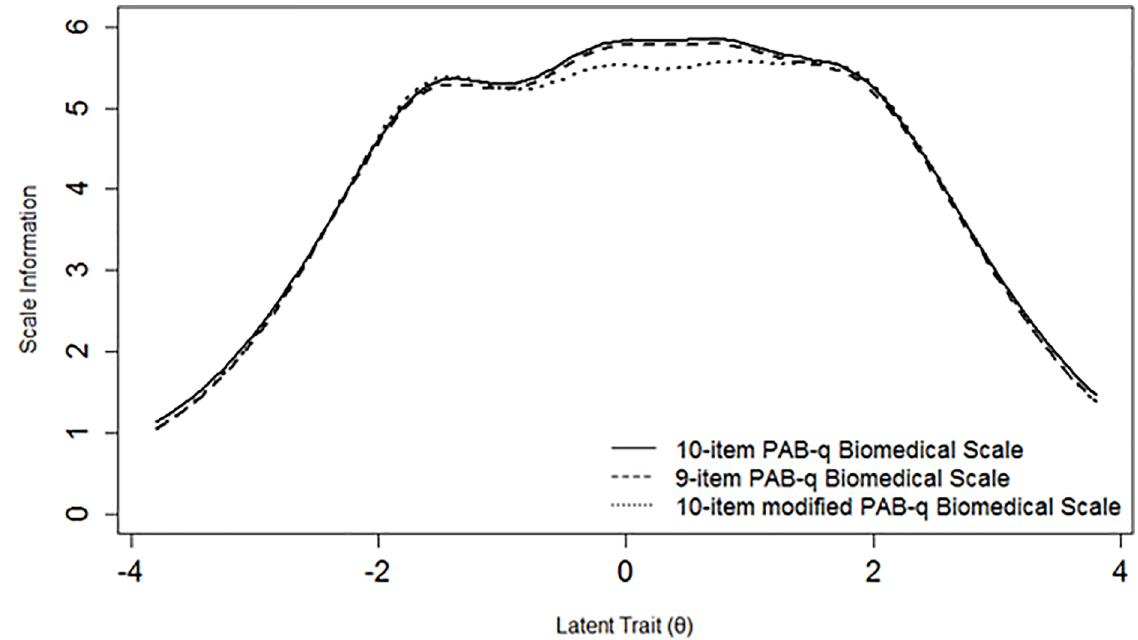
Fig 4. Scale information functions for three versions of the biomedical scale of the Pain Attitudes and Beliefs Scale (PABS) in the DABS study.